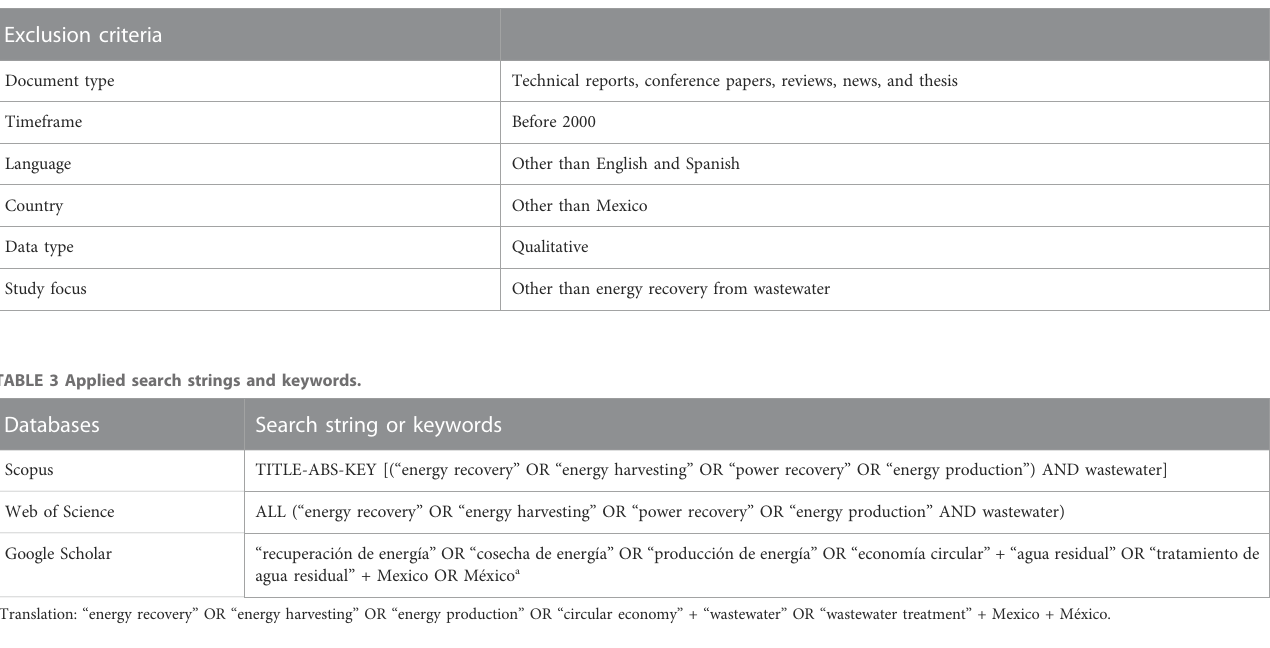
TABLE 2 Exclusion criteria for studies to be